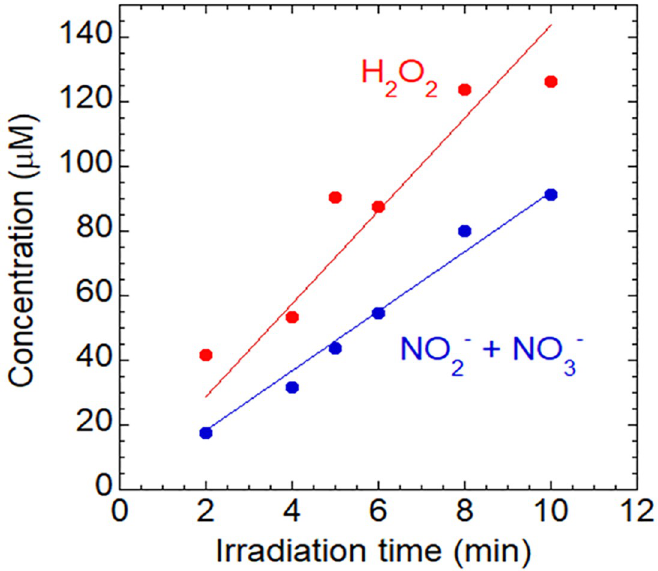
Fig 2. H 2 O 2 and the sum of NO 2- and NO 3- concentrations in APPJ-irradiated ultrapure water as a function of the exposure